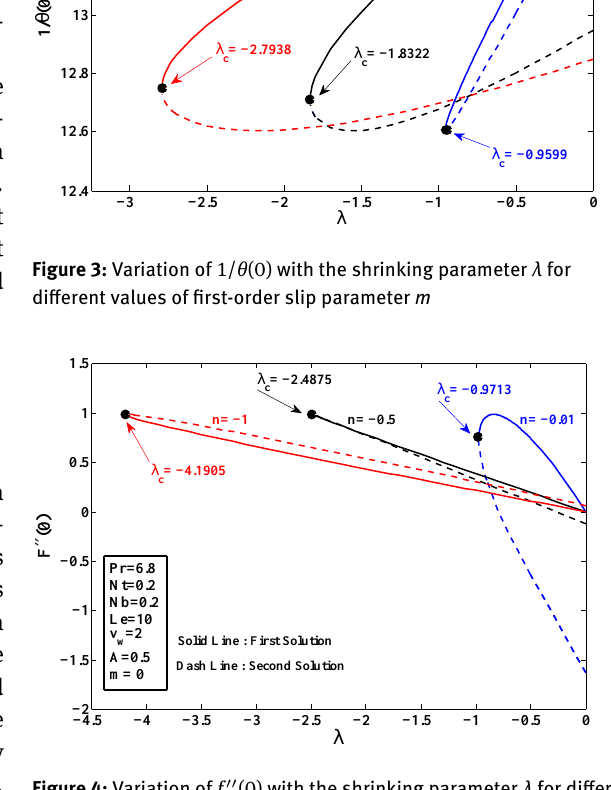
Figure 4: Variation of f (cid:48)(cid:48) (0) with the shrinking parameter λ for differ- ent values of second-order slip parameter